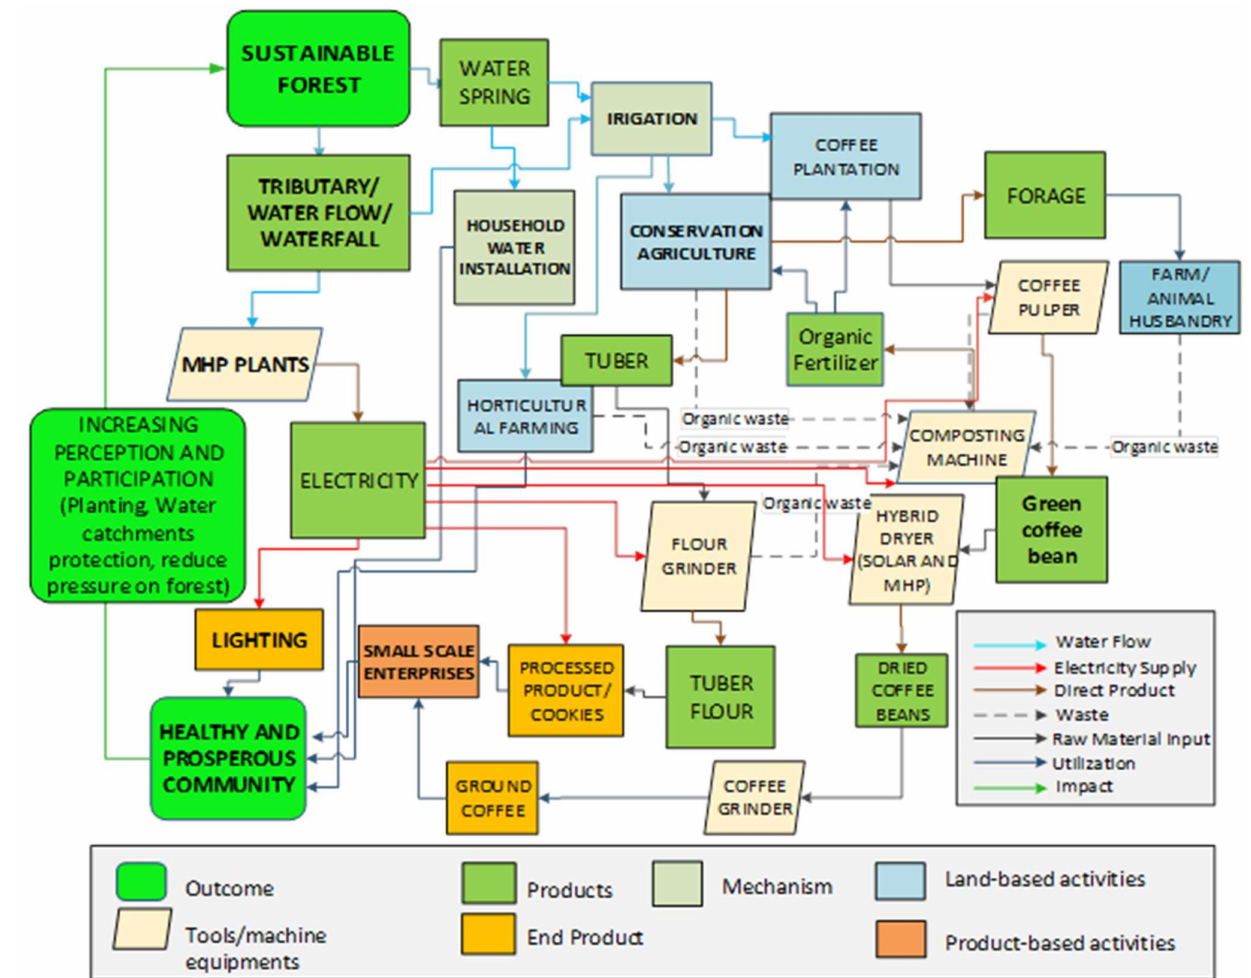
Figure 3. Extensive and integrated development of MHP utilization in Bantaeng and